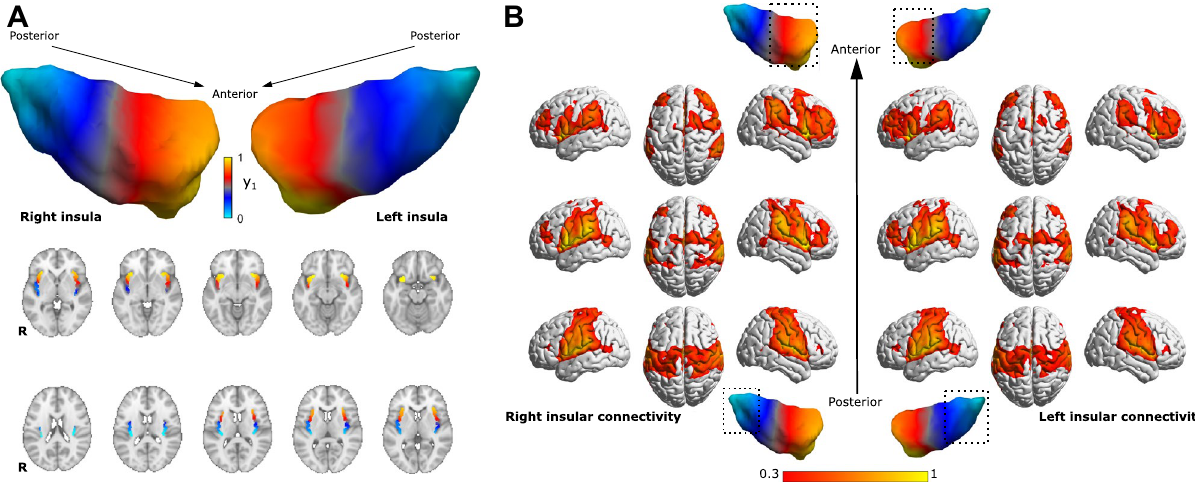
Figure 1. Average connectopy of the insular cortex. ( A ) Average connectopic maps overlaid on the MNI152 template, displayed in neurological orientation. Bilateral insular cortices show a similar posteroanterior trajectory of change in functional connectivity profiles. y 1 : dominant connectopy. ( B ) Heatmaps showing the voxel wise probability of Z-transformed correlation > 2 with the anterior, posterior and middle part of the right insula taken over all participants, overlaid on the ICBM152 template in neurological orientation. Masks for different parts of the insula were derived by dividing the average connectopy into three parts (0 < 0.3 < 0.7 < 1). 3D representations were created using BrainNet Viewer 42